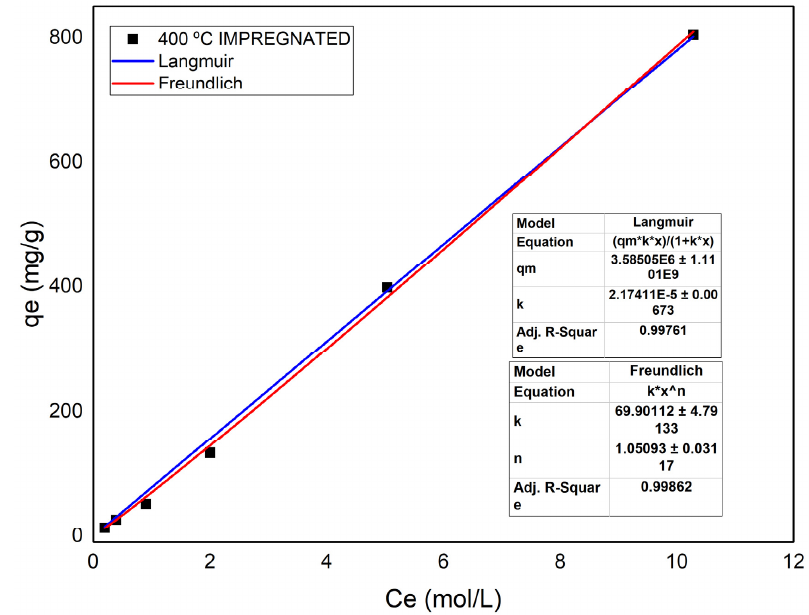
Figure 16. Langmuir and Freundlich isotherm model for adsorption experiment of chemically activated biochar obtained at 400 °C.